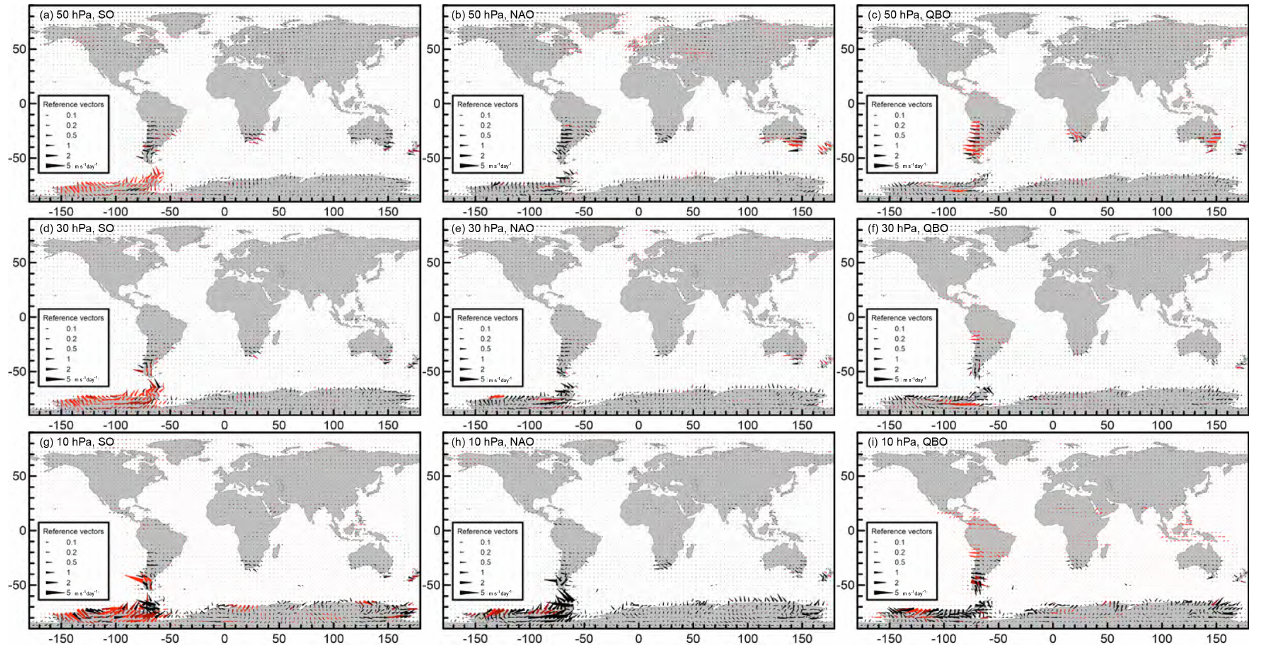
Figure 4. Response of the OGWD (ms − 1 day − 1 ) at the 50hPa (a, b, c) , 30hPa (d, e, f) and 10hPa (g, h, i) level related to the activity of the Southern Oscillation (a, d, g) , North Atlantic Oscillation (b, e, h) and quasi-biennial oscillation (c, f, i) . The responses correspond to the increase in the oscillation index by 4 times its SD, i.e., to the transition of the respective oscillation from a highly negative to a highly positive phase; red symbols pertain to locations with at least one wind tendency component response statistically significant at the 95% confidence level; bright red indicates at least one component significant at the 99% confidence level. Analysis period: 1979–2010, monthly data, JJA